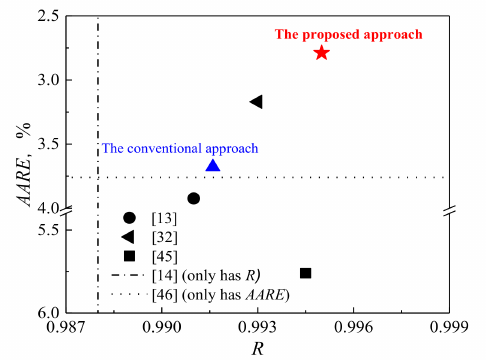
Figure 6. The R and AARE for modified Arrhenius-type models constructed by the proposed approach in present work and by other